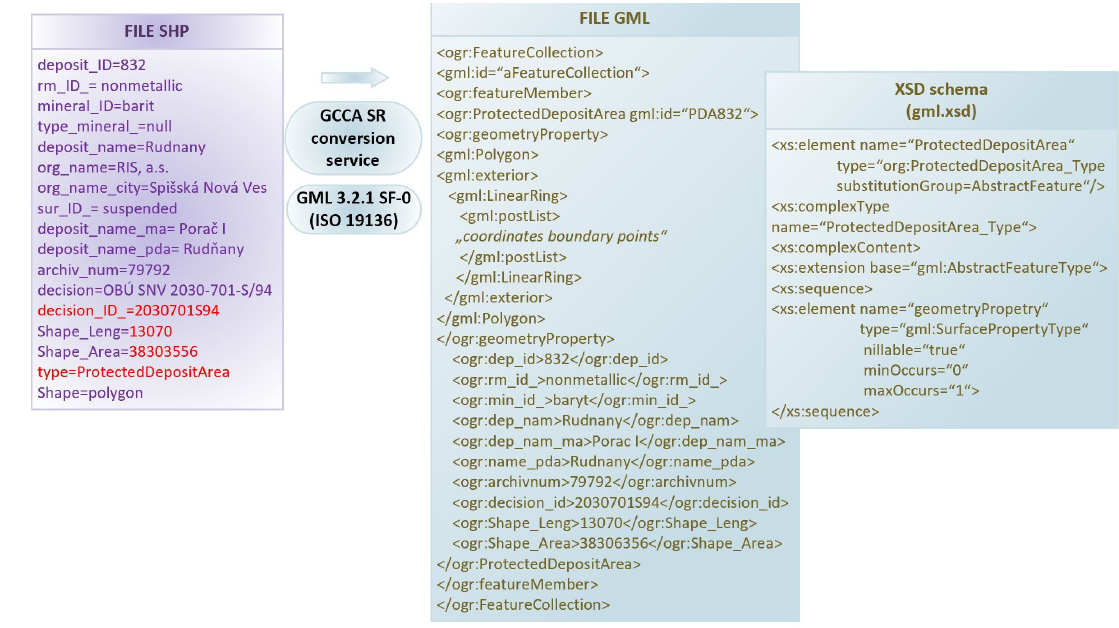
Land 2022 , 11 , x FOR PEER REVIEW Figure 10. Example of extended shapefile content to GML file content. Figure 10. Example of extended shapefile content to GML file content.